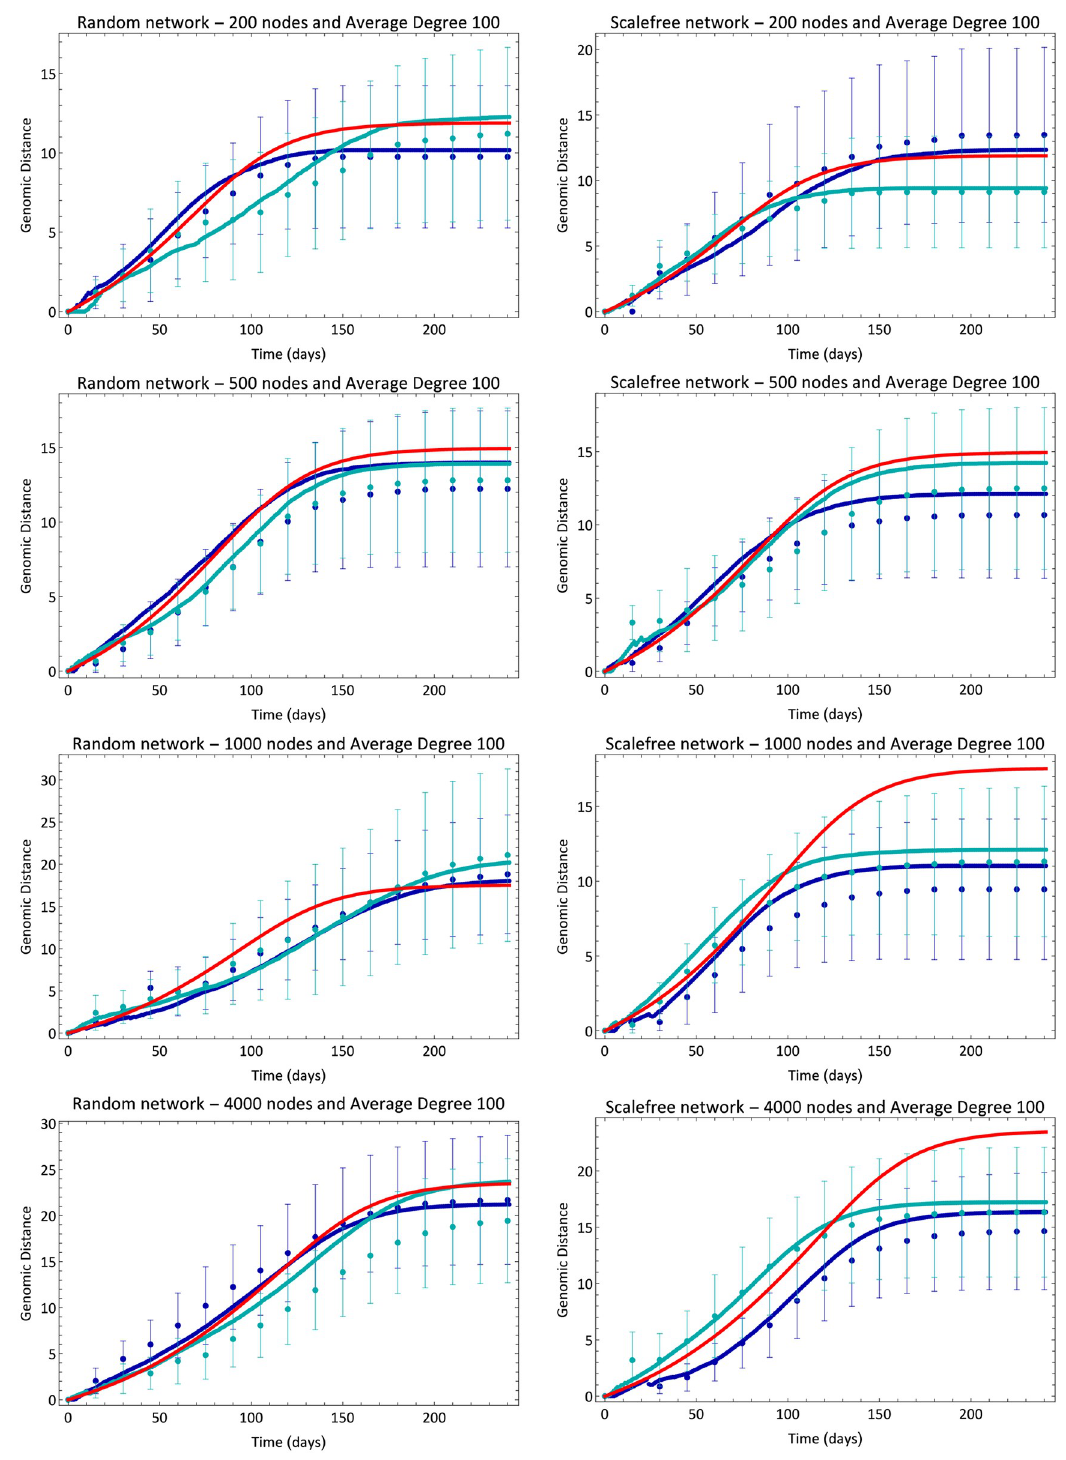
Fig 2. Evolution of average genetic distance. Blue lines and dots are, respectively, analytical (Eq (2)) and simulation results for different simulations. Different shades of blue correspond to different simulations for the same set of parameters. The red line shows the result of mean-field Eq (3). Error bars are standard deviation of the distance distribution in each simulation at each time.